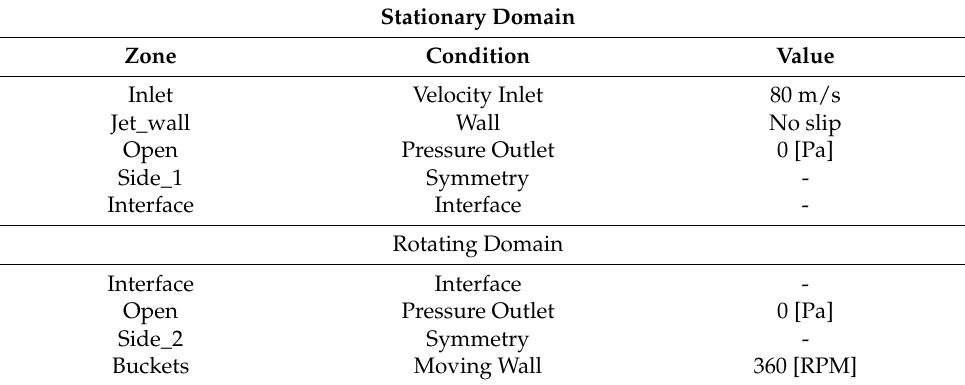
Table 2. Boundary Conditions for numerical study.